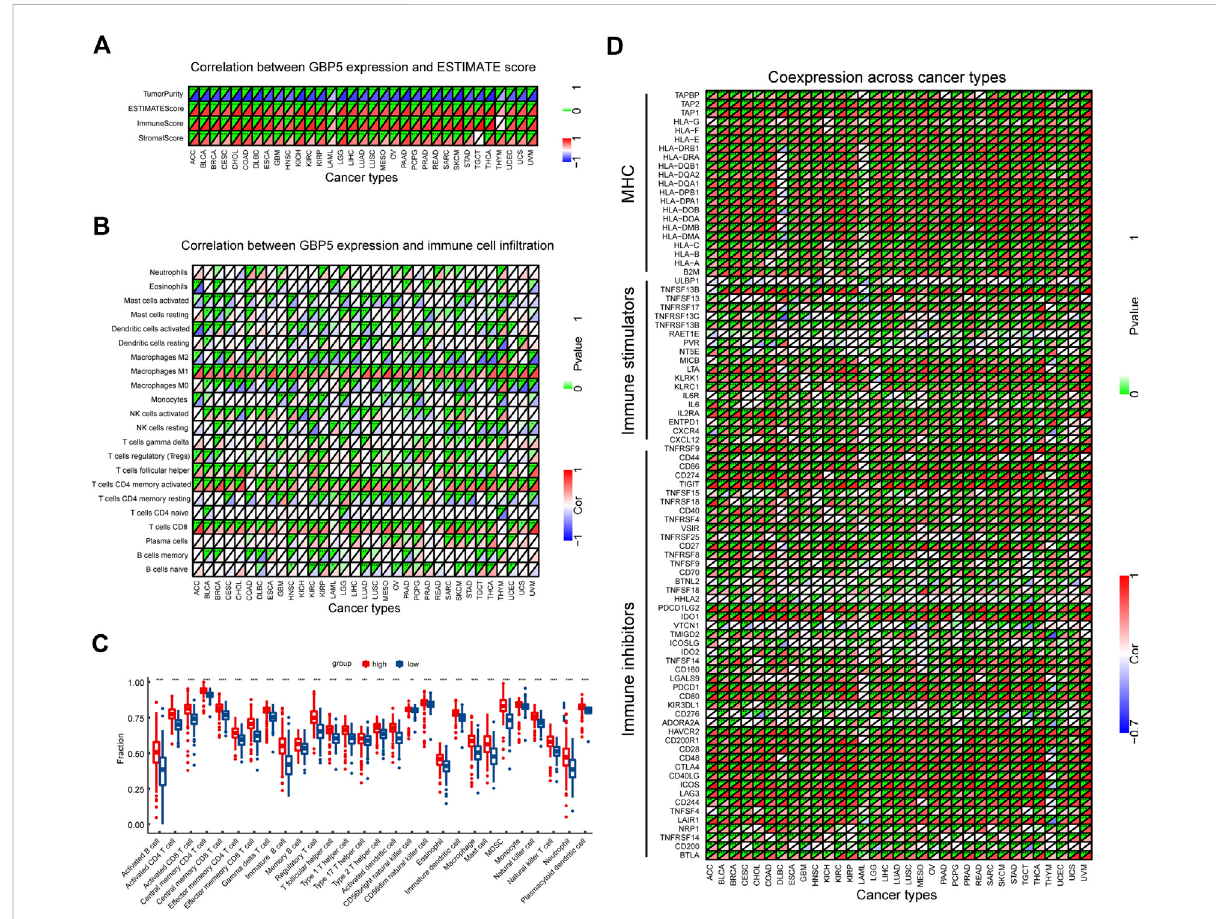
FIGURE 4 Correlation between GBP5 and TME in pan-cancer (A) Correlation between GBP5 and ESTIMATE score. (B) Correlation between GBP5 and the in fi ltration level of TIICs (tumor-in fi ltrating immune cells) by CIBERSORT (C) Differences of the fraction of TIICs by GSEA (gene set enrichment analysis)betweenGBP5highandlowexpressiongroupsinCRC (D) TheexpressioncorrelationbetweenGBP5andimmune-relatedgenes.Sortedby correlation values in COAD, the top ten genes were PDCD1LG2 (R = 0.881840593), CD274 (R = 0.865101814), CD86 (R = 0.84128397), TIGIT (R = 0.838645959), HAVCR2 (R = 0.815956551), TNFRSF9 (R = 0.813663547), LAIR1 (R = 0.788751933), CD80 (R = 0.787116939), ICOS (R = 0.767427362), and CTLA4 (R = 0.760401416). “ * ” indicates p < 0.05, “ ** ” indicates p < 0.01 and “ *** ” indicates p <